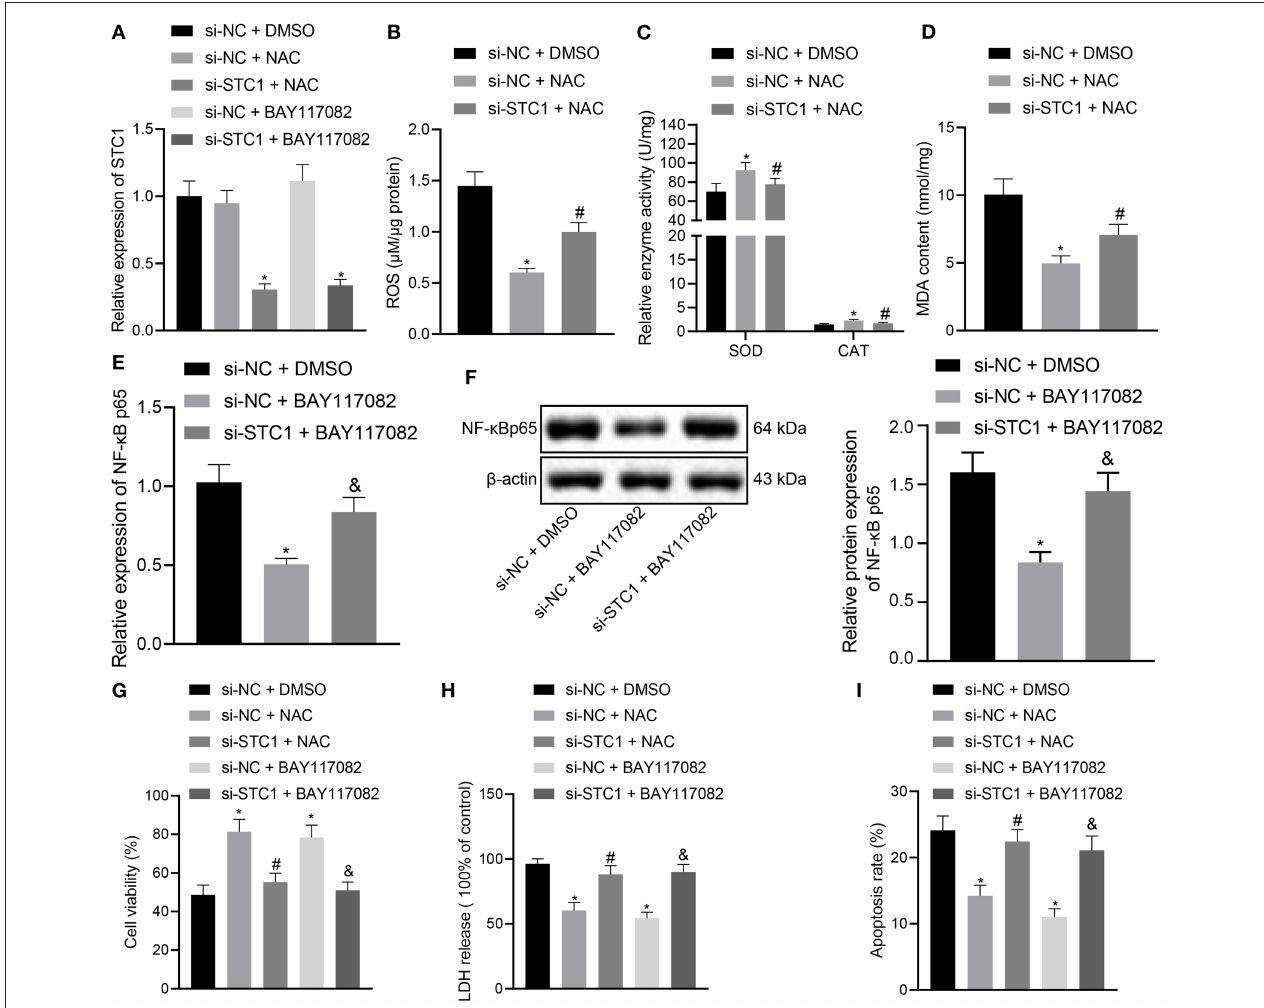
FIGURE 5 | STC1 overexpression inhibits the ROS/NF- κ B signaling pathway to repress toxicity and apoptosis of hippocampal neurons induced by CORT. (A) STC1 mRNA expression in hippocampal neurons induced by CORT determined by RT-qPCR after different treatments. (B) ROS production in hippocampal neurons induced by CORT after different treatments. (C) SOD and CAT activity in hippocampal neurons induced by CORT after different treatments. (D) MDA level in hippocampal neurons induced by CORT after different treatments. (E) NF- κ B p65 mRNA expression in hippocampal neurons induced by CORT determined by RT-qPCR after different treatments. (F) NF- κ B p65 protein expression in hippocampal neurons induced by CORT measured by Western blot assay after different treatments. (G) viability of hippocampal neurons induced by CORT after different treatments. (H) LDH activity in hippocampal neurons induced by CORT after different treatments. (I) apoptosis of hippocampal neurons induced by CORT after different treatments. * p < 0.05 vs. neurons treated with si-NC + DMSO. # p < 0.05 vs. neurons treated with si-NC + NAC. & p < 0.05 vs. neurons treated with si-NC + BAY117082. Cell experiment was repeated 3